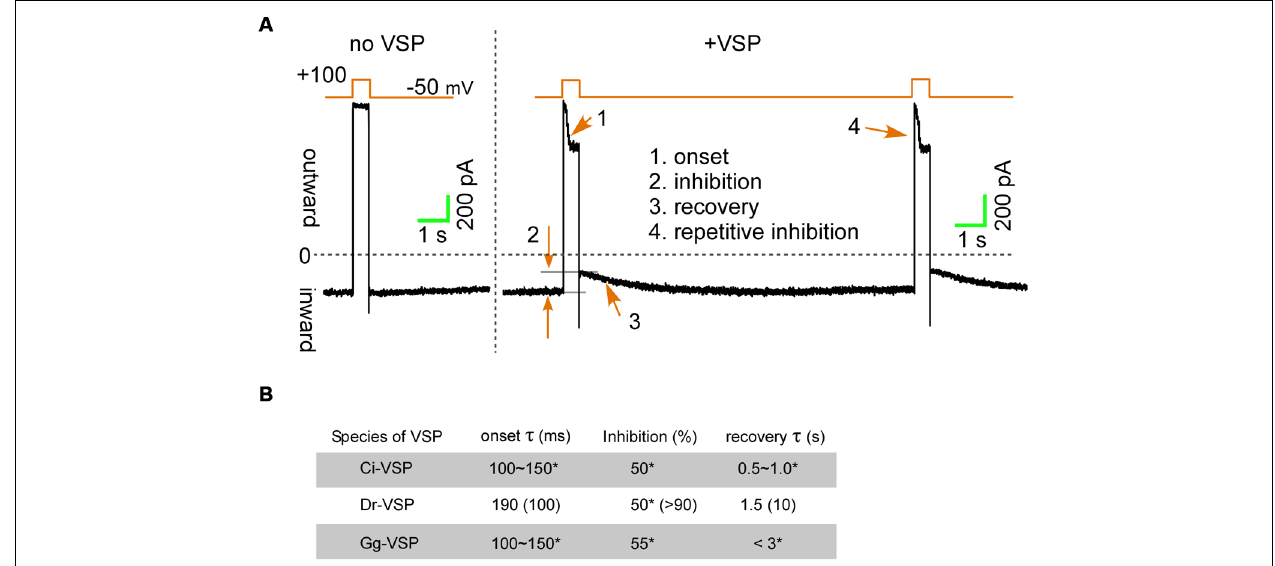
FIGURE 2 |The inhibition upon the voltage-sensing phosphatases (VSPs) activation. (A) TRPC6 currents induced by a DAG analog (OAG) are transiently inhibited by Dr-VSP activation (Imai etal., 2012). (B) Inhibitory effects of VSPs on TRPC6 and KCNQ2/3 channels. Data for TRPC6 channels are from Imai etal.